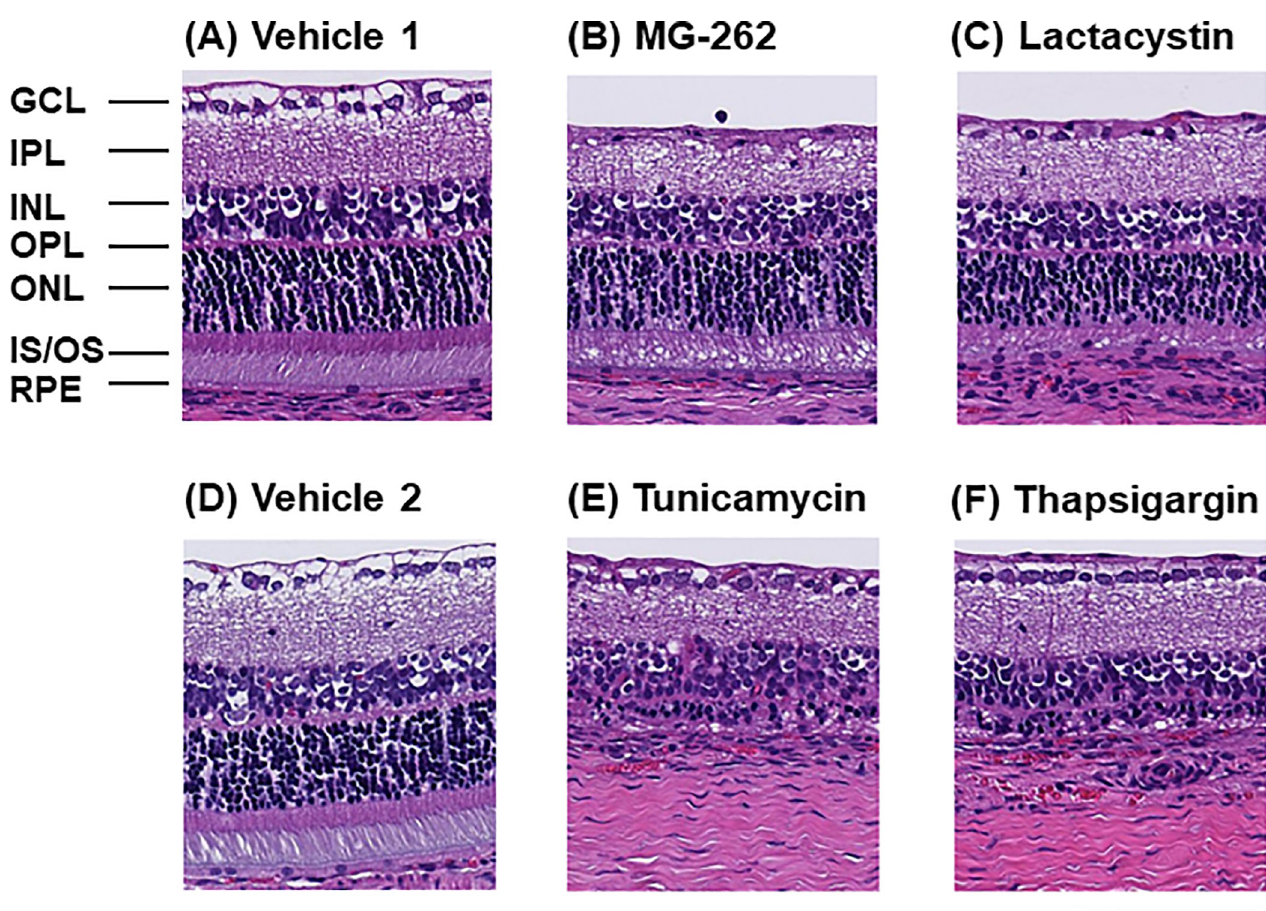
Fig 1. Retinal degeneration induced by MG-262, lactacystin, tunicamycin and thapsigargin in the normal adult rat eyes. Each photograph shows the representative image of cross-sectioned retina 7 days following intravitreal injection of vehicle (A and D, 10% DMSO in D-PBS), MG-262 (B, 0.27 nmol/eye), lactacystin (C, 10 nmol/eye), tunicamycin (E, 2.5 nmol/eye), and thapsigargin (F, 10 nmol/eye). The scale bar shows 100 μ m. GCL: ganglion cell layer; IPL: inner plexiform layer; INL: inner nuclear layer; OPL: outer plexiform layer; ONL: outer nuclear layer; IS/OS: photoreceptor inner and outer segments; RPE: retinal pigment